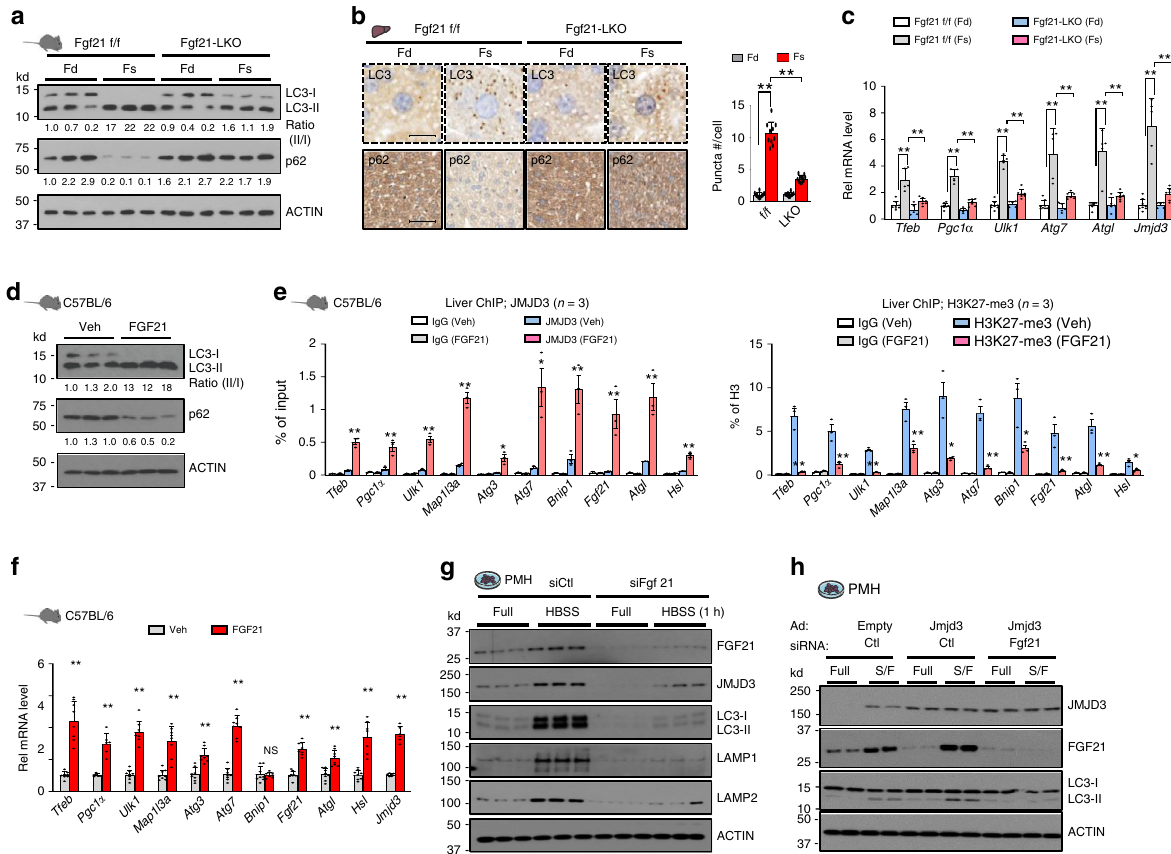
Fig. 3 Fasting-induced FGF21 promotes hepatic autophagy. a – c FGF21 fl oxed or FGF21-LKO mice were fasted (Fs) for 24 h, or refed (Fd) for 24 h after fasting. a LC3 and p62 levels in liver extracts detected by IB. The ratios of the LC3-II/I and p62 band intensities are shown below the blot. ( n = 3 mice). b LC3 or p62 was detected by IHC analysis. Representative images of liver sections and the average number of LC3-II puncta/cell (right, n = 10 hepatocytes) are shown (scale bar = 10 μ m for LC3, 50 μ m for p62). c The mRNA levels of the indicated genes measured by q-RTPCR ( n = 5 – 8 mice). d The indicated hepatic proteins detected by IB with the ratios of the LC3-II/I with the band intensities of p62 relative to the fi rst lane shown below the blot ( n = 3 mice). e , f C57BL/6 mice were treated with FGF21 (0.1 mg/kg) for 3 h. e Effects of FGF21 on occupancy of JMJD3 (left) and H3K27-me3 levels (right) at the indicated genes ( n = 3 mice). f Hepatic mRNA levels measured by q-RTPCR ( n = 6 – 8 mice). g Effects of siRNA-mediated downregulation of FGF21 on levels of indicated proteins in PMH incubated with M199 or HBSS medium. h PMH were transfected with siFGF21 or control RNA for 48 h and infected with Ad-JMJD3 or Ad-empty for 24 h. Cells were cultured in serum-free or complete M199 medium for 12 h and levels of the indicated proteins were determined by IB ( n = 2 culture dishes). Source data are provided as a Source Data fi le. All values are presented as mean ± SD. Statistical signi fi cance was measured using the f Mann – Whitney test or b , c , e two-way ANOVA with the Bonferroni post-test. * P < 0.05, ** P < 0.01, and NS statistically not signi fi are known to promote autophagy, PPAR α 7,9 , CREB 8 , and FOXO1 12 . The increase in the LC3-II/I ratio induced by JMJD3 expression was largely blocked by downregulation of PPAR α , while a substantial increase was still observed after down-